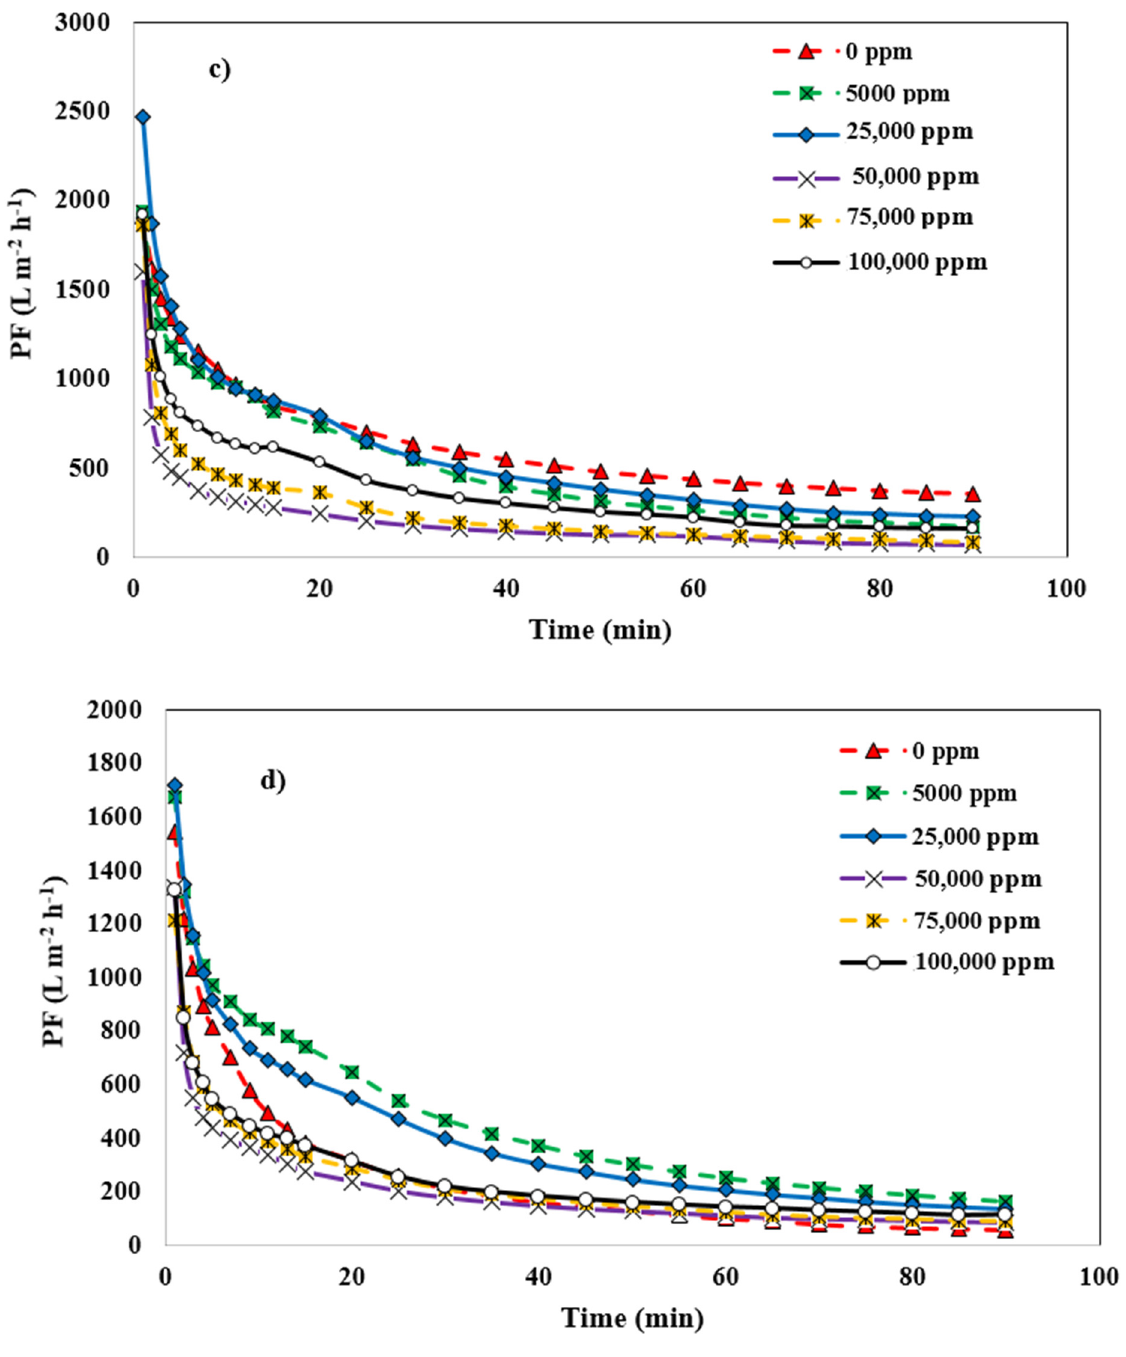
Figure 8. Effect of salt concentration on PF of membranes ( a ) mullite, ( b ) mullite-alumina, ( c ) mul- lite-alumina-zeolite, ( d ) mullite-zeolite. alumina-zeolite, ( d )